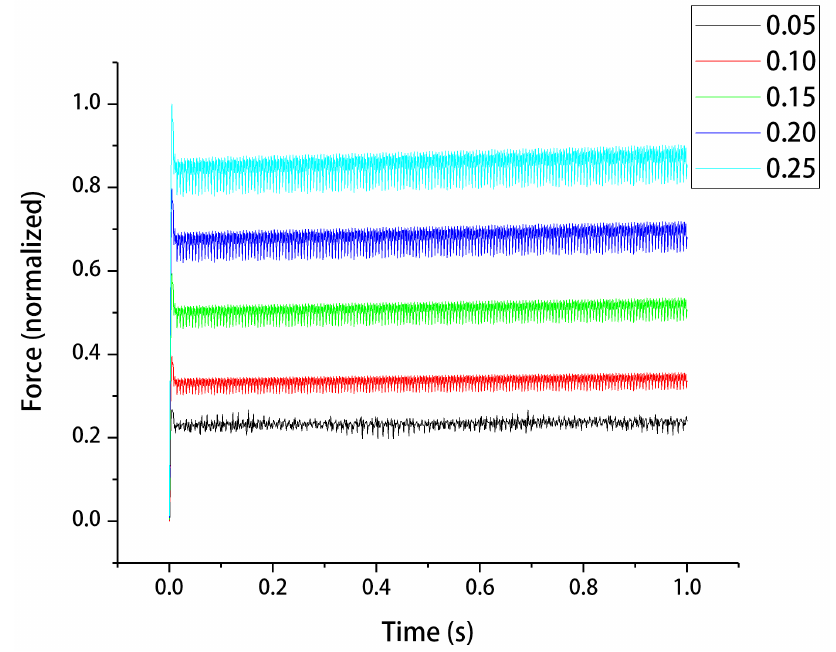
Figure 12. The nodal force of the unbalanced magnetic pull on the rotor.